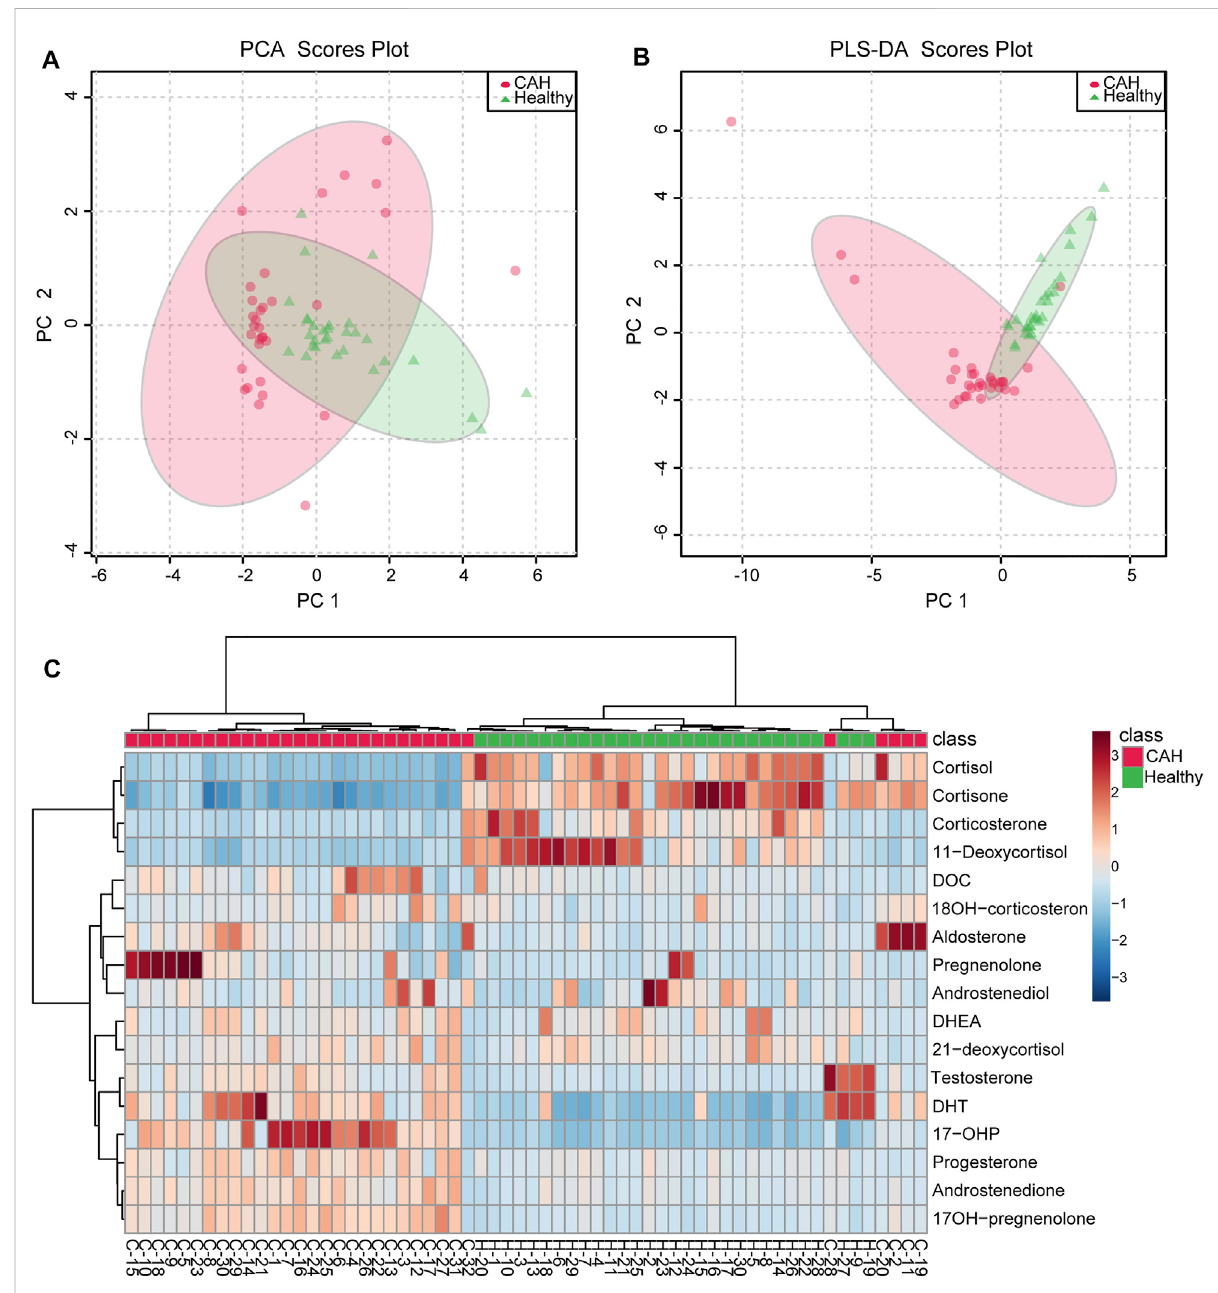
FIGURE 4 MultivariatestatisticalanalysisforCAHpatients(redcircle)andhealthyvolunteers(greentriangle). (A) PCAscoreplotsofthemultivariatedataof 17differentialhormones. (B) PLS-DAscoreplotbasedon17differentialhormones. (C) Heatmaprepresentsfor17hormonesconcentrationchangein CAH patients and healthy volunteers. Red color indicates relative enrichment, whereas blue indicates relative